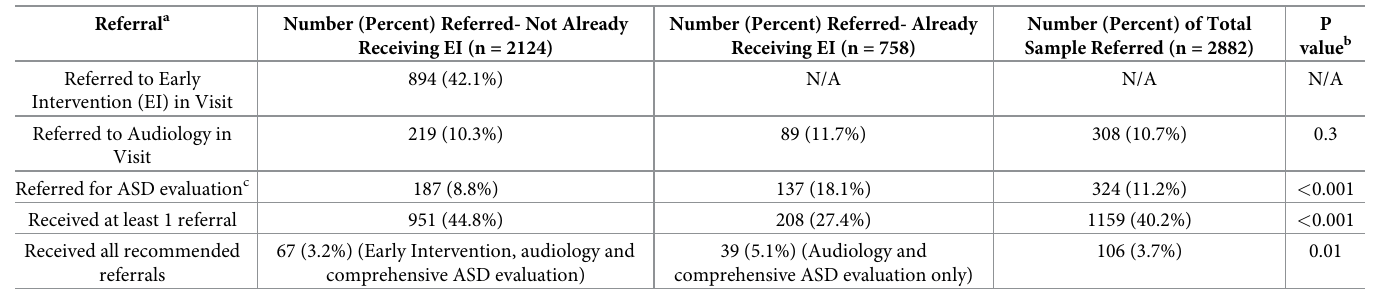
Table 3. Referrals made on day of visit for children with positive ASD